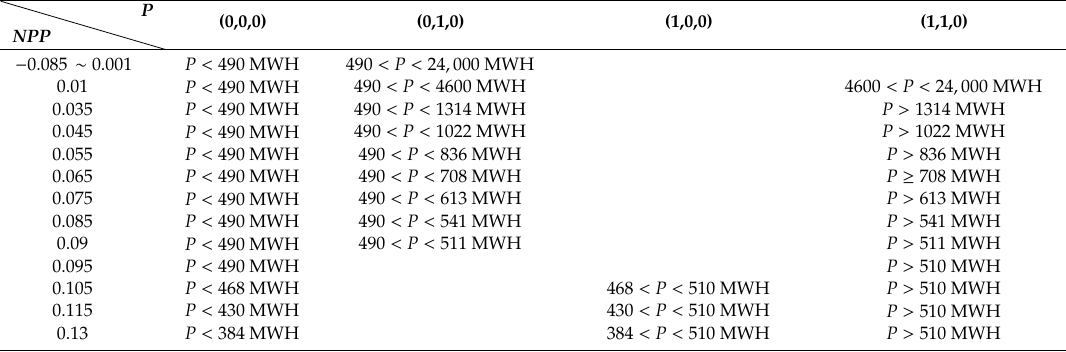
Table A1. Influence of NPP on the power generation decisions of power